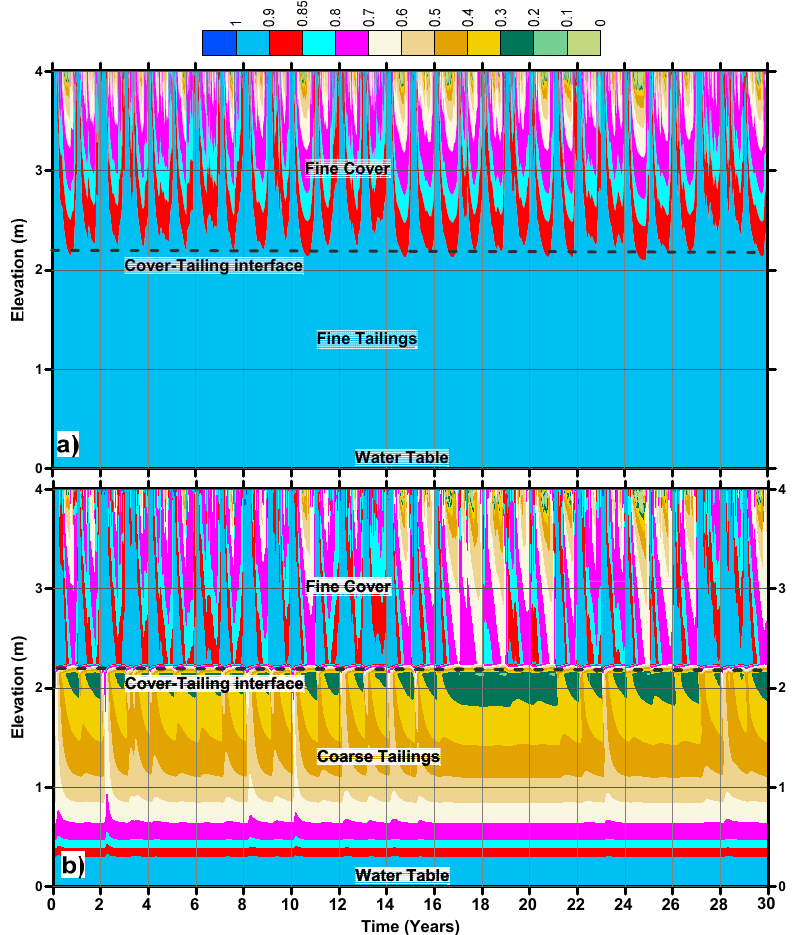
Figure 13. Comparison of 30-year time histories of saturation with depth for ( a ) FF profile, ( b ) FC profile.